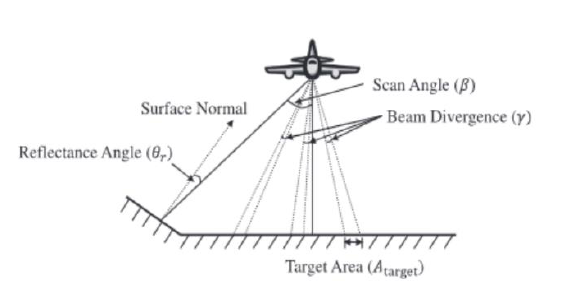
Figure 4. Illustration of the reflected angle θ for a laser beam (Yan et al.,